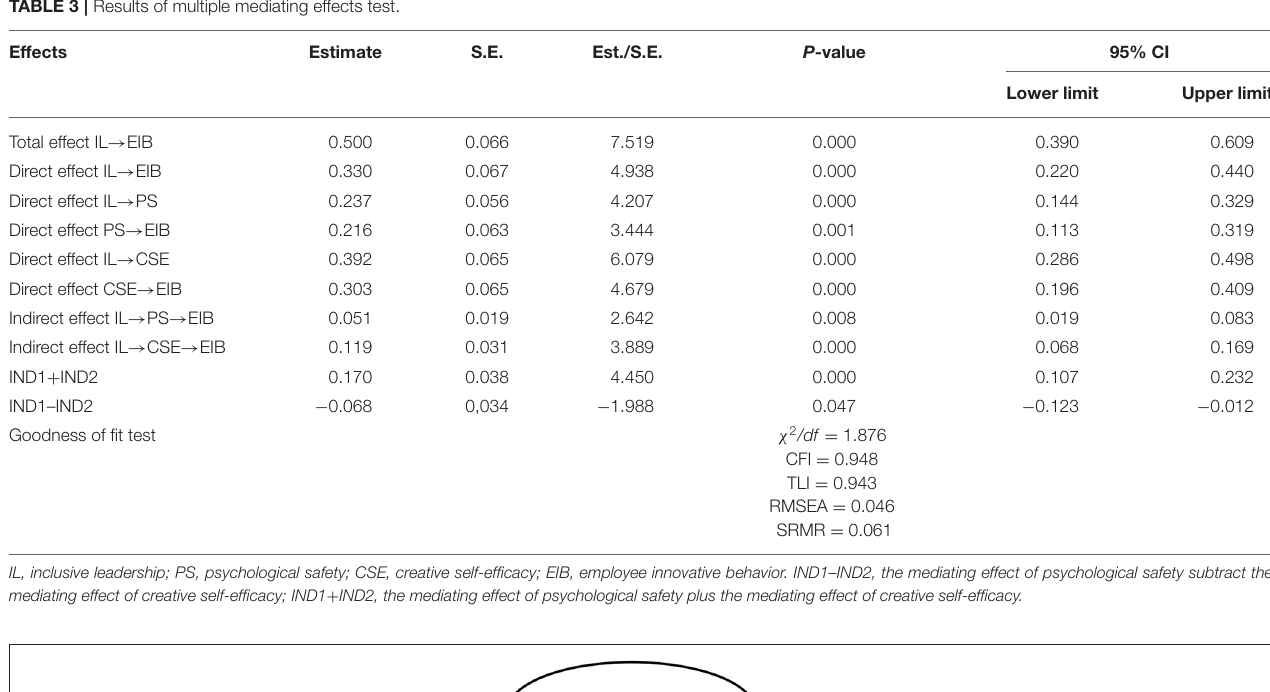
TABLE 3 | Results of multiple mediating effects test.